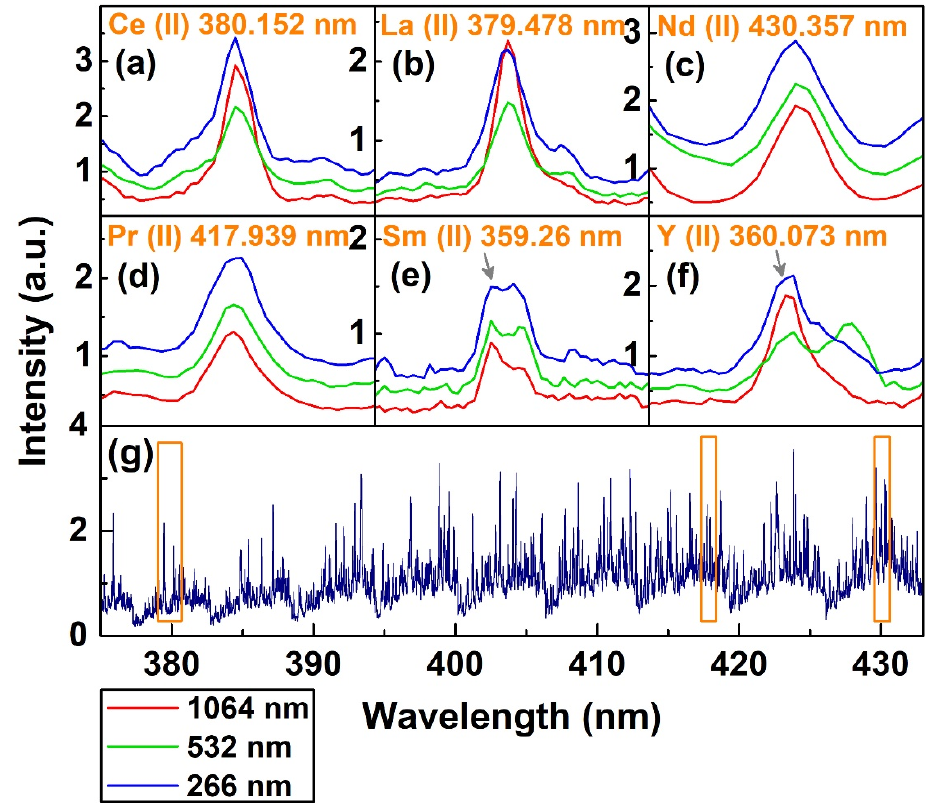
Figure 6. ( a – f ) Variation in intensity of different emission lines with changing laser wavelength, and ( g ) a representative spectrum of monazite with 266 nm laser ablation. The orange squares highlighted 4 of the 6 lines presented in Figure 6 ( a – f ). Table 3. The emission lines of different REEs in monazite.